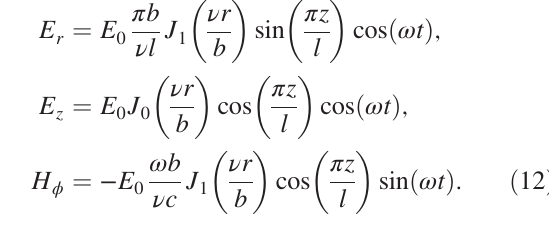
, see text. Parameters eq